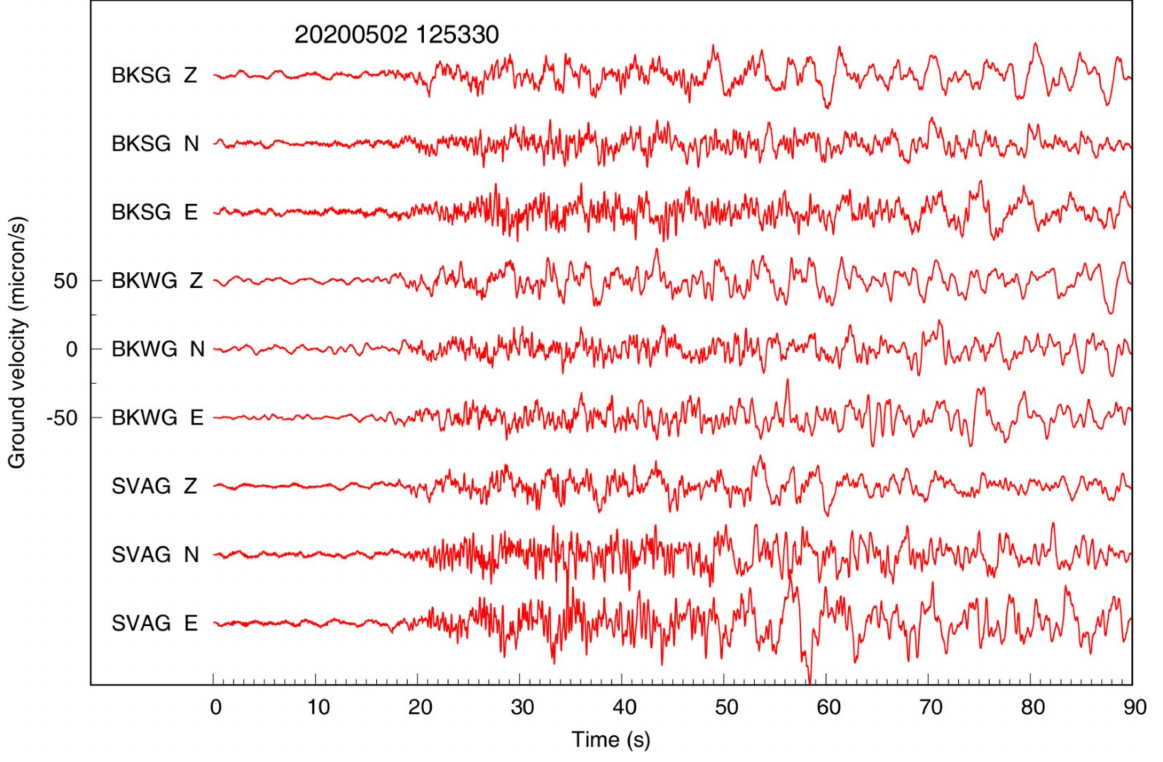
Figure 6. Regional earthquake (20200502 12:51:05 UTC, latitude 34.14 ◦ N, longitude 25.70 ◦ E, depth 10 km, Mw6.6 Crete, Greece) recorded by BKSG, BKWG and SVAG